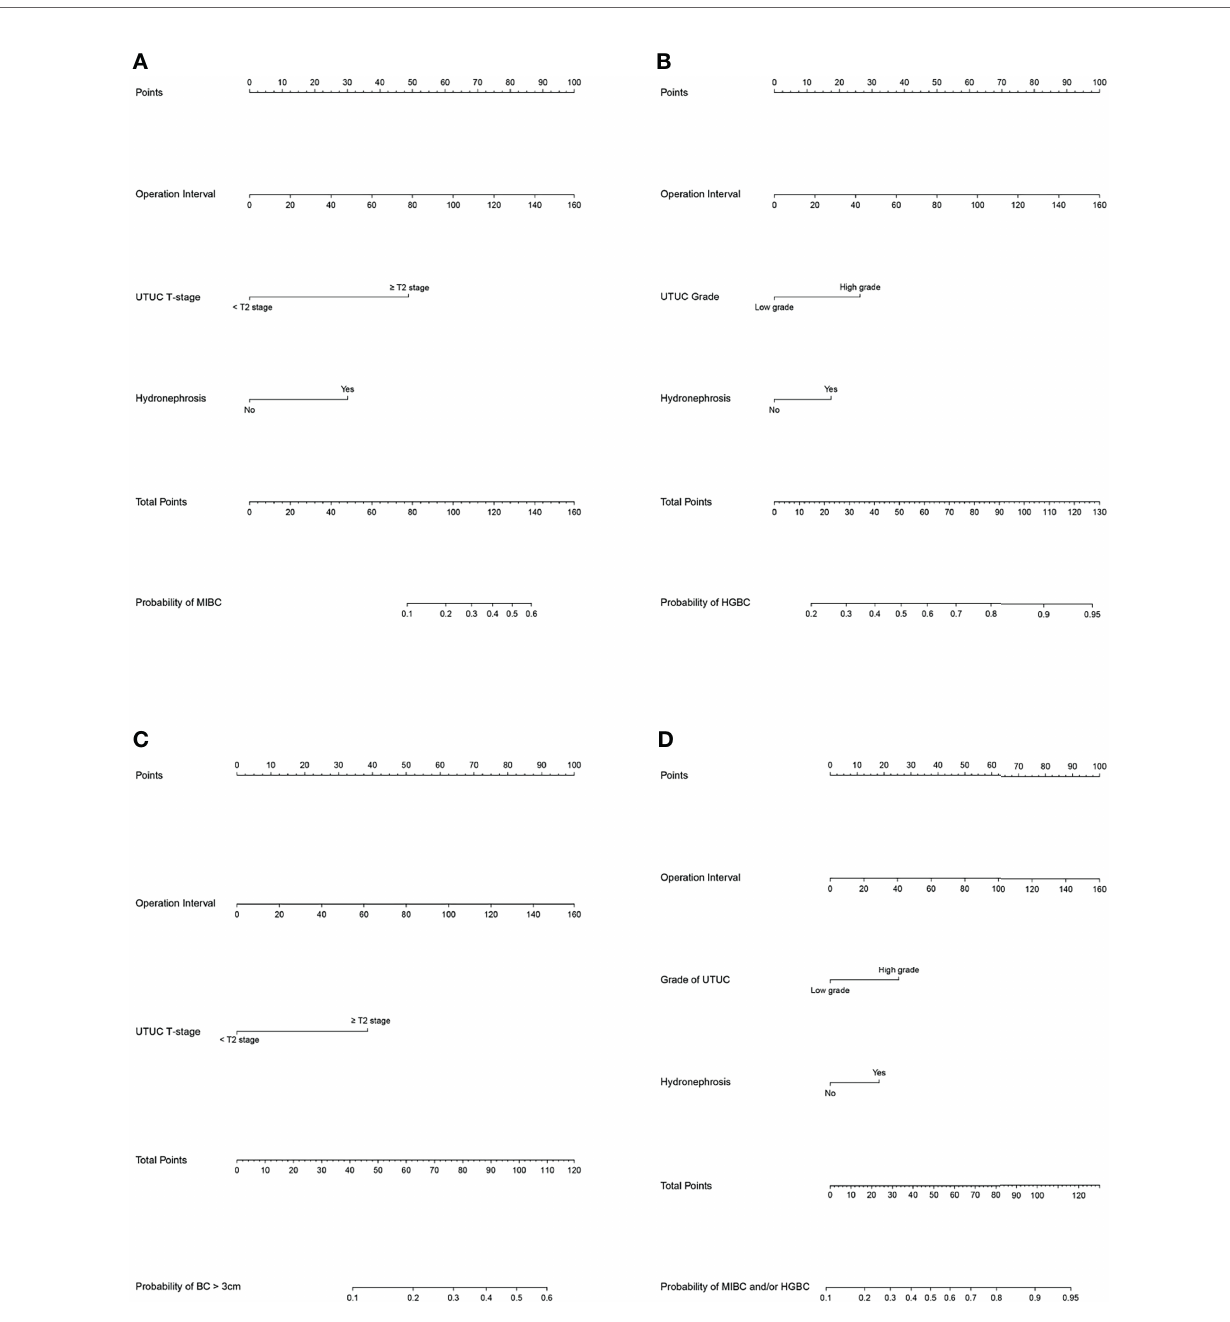
FIGURE 1 | Nomograms for the prediction of unfavorable pathological types intravesical recurrence (IVR) following radical nephroureterectomy (RNU). (A) Nomogram to predict the risk of muscle-invasive bladder cancer (MIBC) after RNU. (A) Bomogram to predict the risk of high-grade bladder cancer (HGBC) after RNU. (C) Nomogram to predict the risk of bladder cancer >3 cm after RNU. (D) Nomogram to predict the risk of MIBC and/or HGBC after RNU. To use the nomogram, fi rst, assign the points of each variable of the patient by drawing a line straight up to the top line labeled “ Points ” . Sum up the points of the risk factors as total points. Then draw a vertical line down from the axis labeled “ Total Points ” to the bottom line to get the predicted possibility of unfavorable pathological types intravesical recurrence (IVR) following